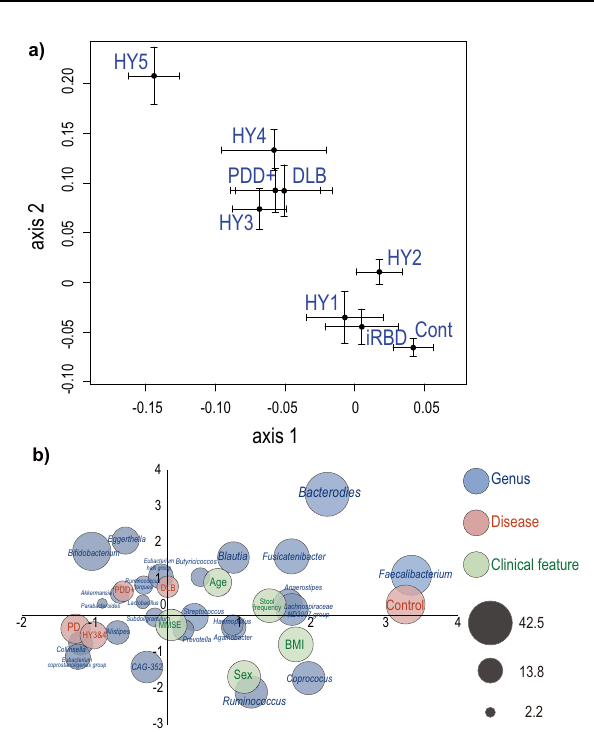
Fig. 2 PCoA and tmap plots. a PCoA plot showing the centers of gravity and the standard errors of the overall compositions of gut microbiota in nine disease states. Bray-Curtis distance was used as a distance metric. b An integrated topological map, tmap , showing how close genera, disease states, and clinical features are to each other. Blue, red, and green circles indicate genera, disease states, and clinical features, respectively. The size of circles indicates the SAFE score, which represents the network-level association of a target feature and is used as an effect